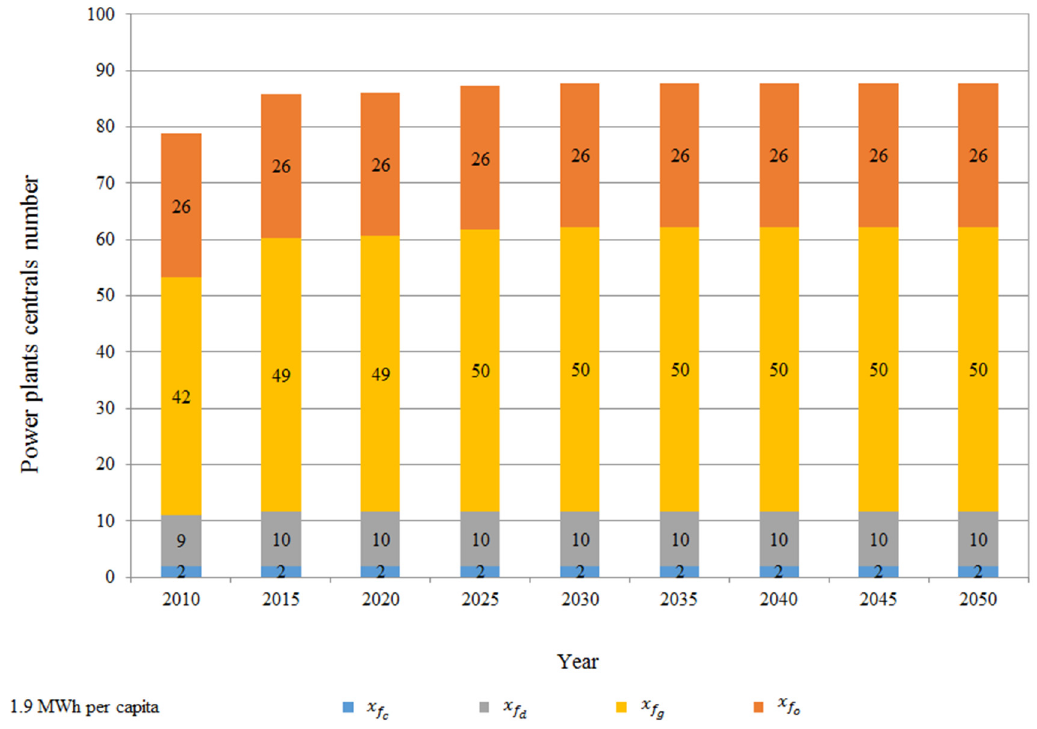
Figure 8. Optimized power plants number from fossil energy resource for 1.9 MWh per capita demand with the LVF model.